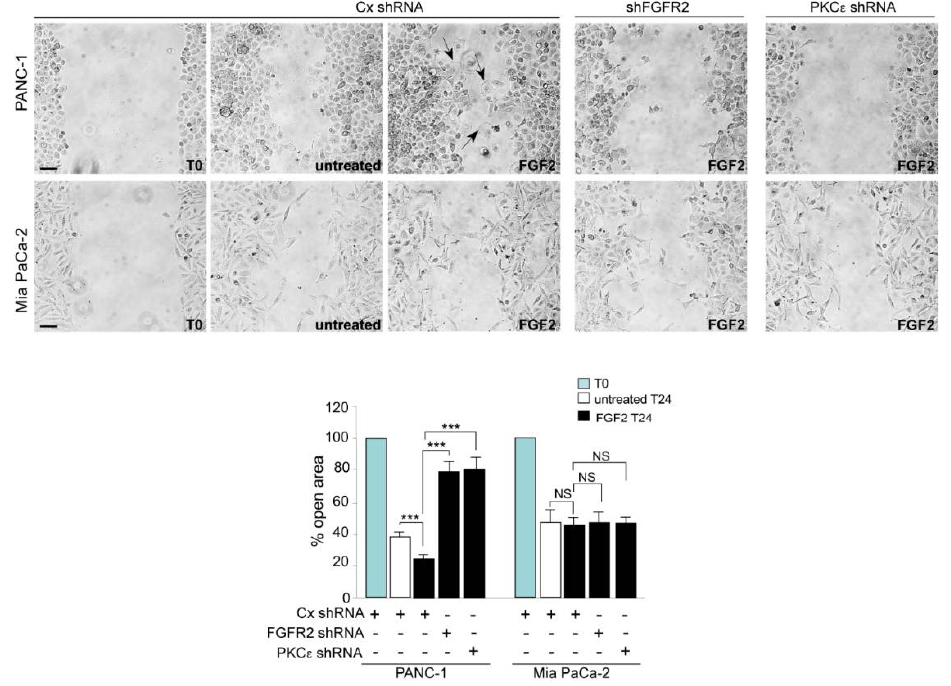
Figure 2. PANC-1 cell migration in response to FGF2 is impaired by FGFR2c or PKC ε depletion. PANC − 1 and MIAPaCa-2 cells were transfected as described above and then grown until